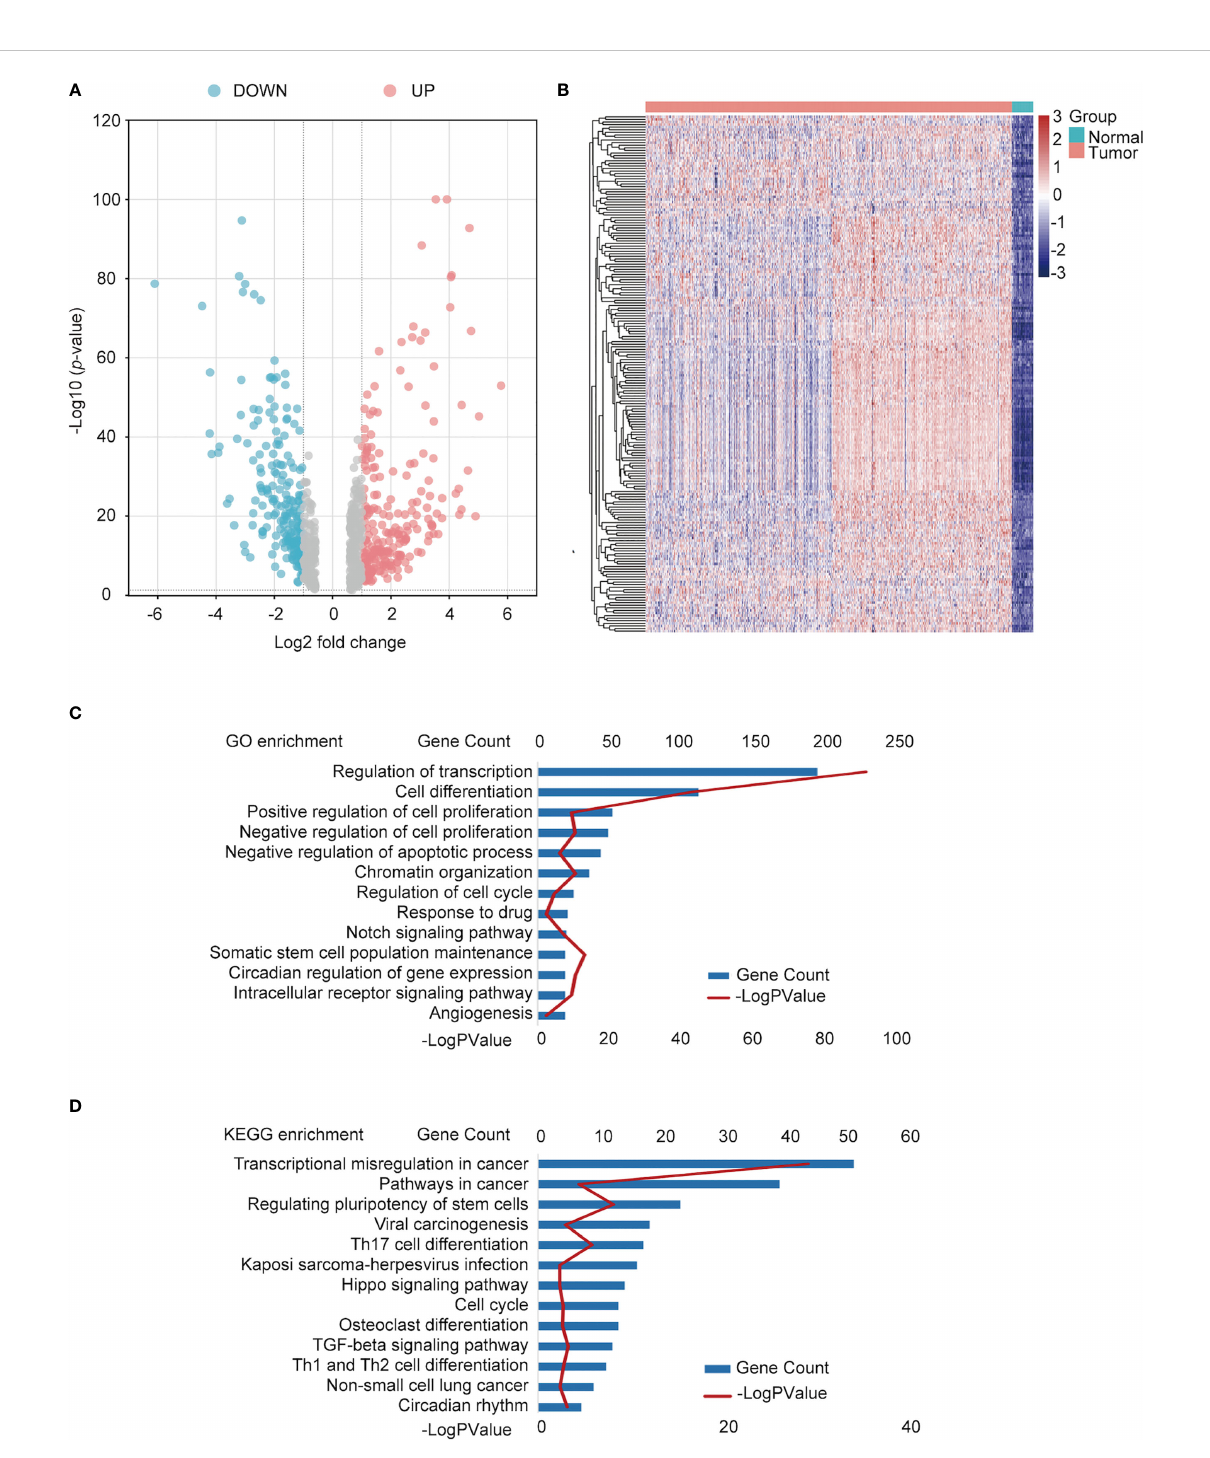
FIGURE 2 Identi fi cation of differentially expressed TFs in NSCLC and normal tissues. (A) Volcano plot of differentially expressed TFs. Red points: upregulated genes; Blue points: downregulated genes. (B) Heatmap of the top upregulated TFs. Green square group: normal tissues; pink square: tumor tissue. (C) Functional annotation of the TFs using Gene Ontology (GO) term. (D) Kyoto Encyclopedia of Genes and Genomes (KEGG) pathway enrichment of differential